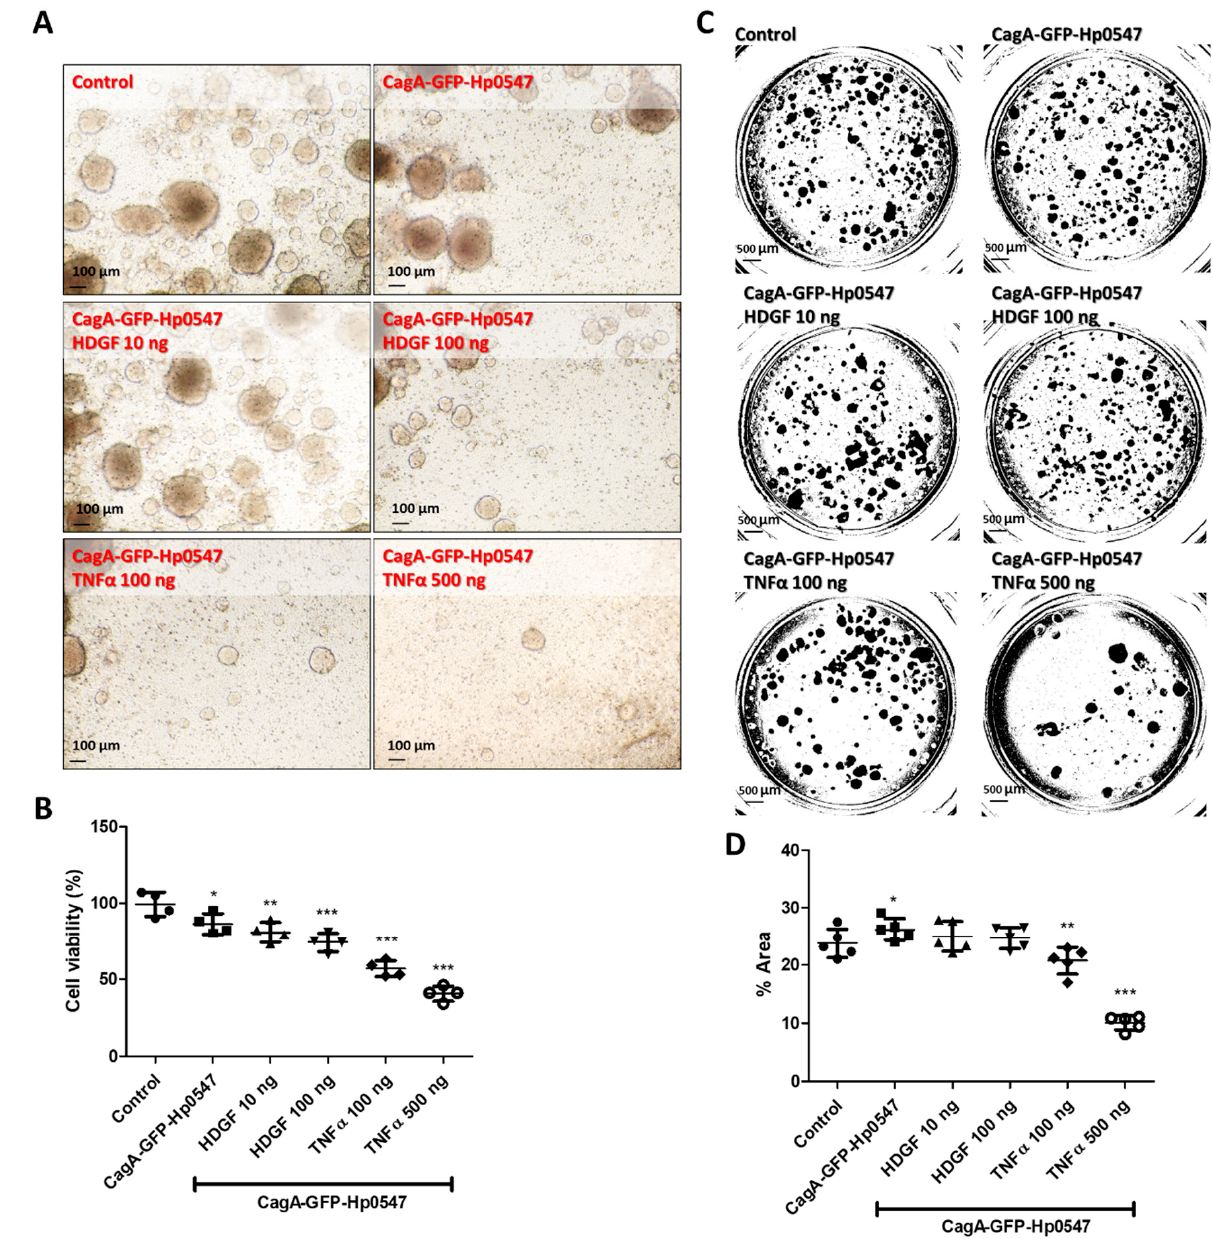
Figure 4. Cell morphologies and viabilities of the CagA-GFP-Hp 0547 labeled organoids after cultivation of organoids in the presence of various dose of recombinant HDGF and TNF α . ( A , B ) The morphologies and viabilities of the gastric organoids HCM-BROD-0045-C16 for 7 days after infection with CagA-GFP-Hp0547 in the presence and absence of indicted doses of recombinant HDGF and TNF α ( n = 4). ( C , D ) The invasion activities of the gastric organoids infected by CagA-GFP- Hp0547 for 7 days in the presence and absence of indicted doses of recombinant HDGF and TNF α . *, **, and *** indicate p < 0.05, p < 0.01, and p < 0.005 ( n = 5), respectively.